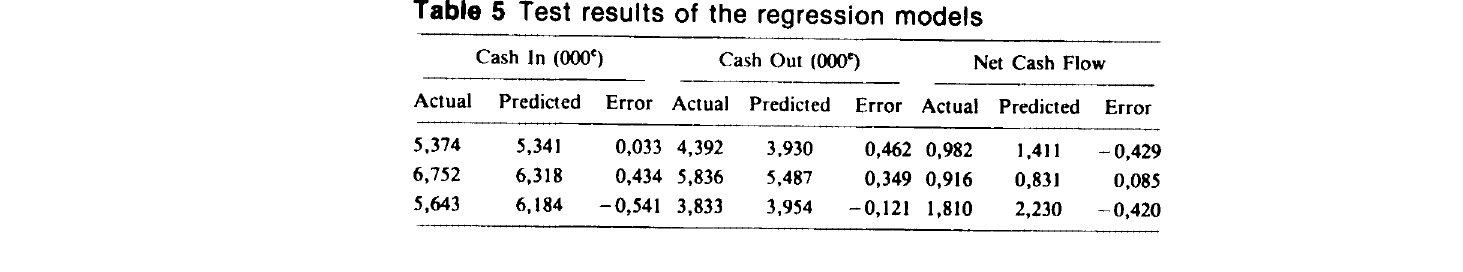
Table 5 Test results of the regression